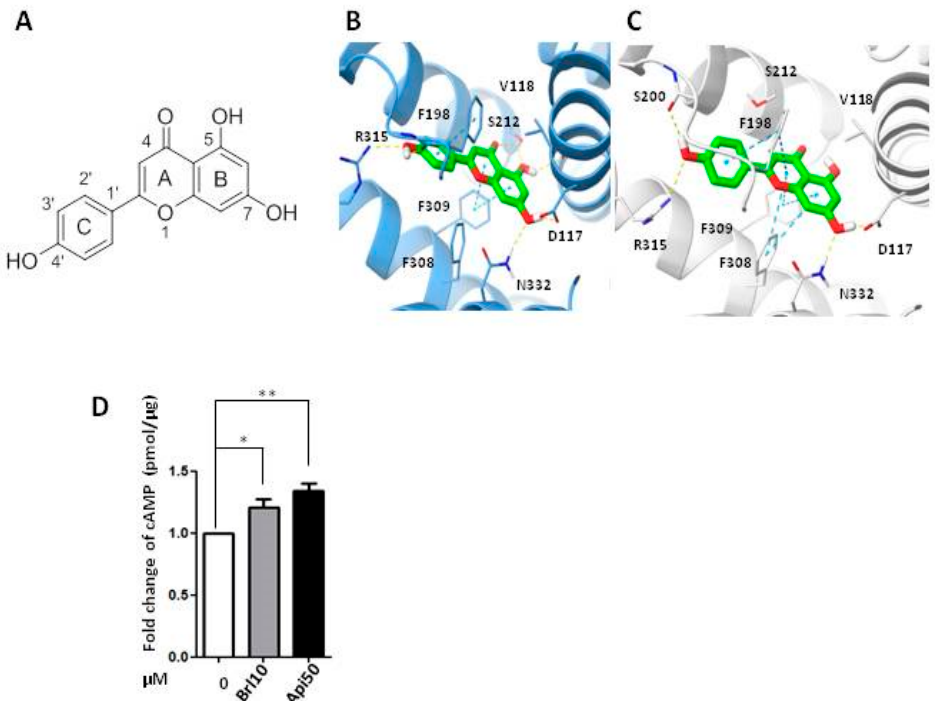
Figure 5. ( A ) Structure of apigenin. ( B,C ) Predicted binding mode of apigenin in the β 3-AR binding pocket of ( B ) HM1 and ( C ) HM2; ( D ) Measurement of cAMP concentration after 30 min of treatment with BRL37344 (10 µ M) and apigenin (50 µ M). Brl10: BRL37344 10 µ M, Apig50: apigenin 50 µ M. p values for treatments: * p < 0.05 and ** p < 0.01.